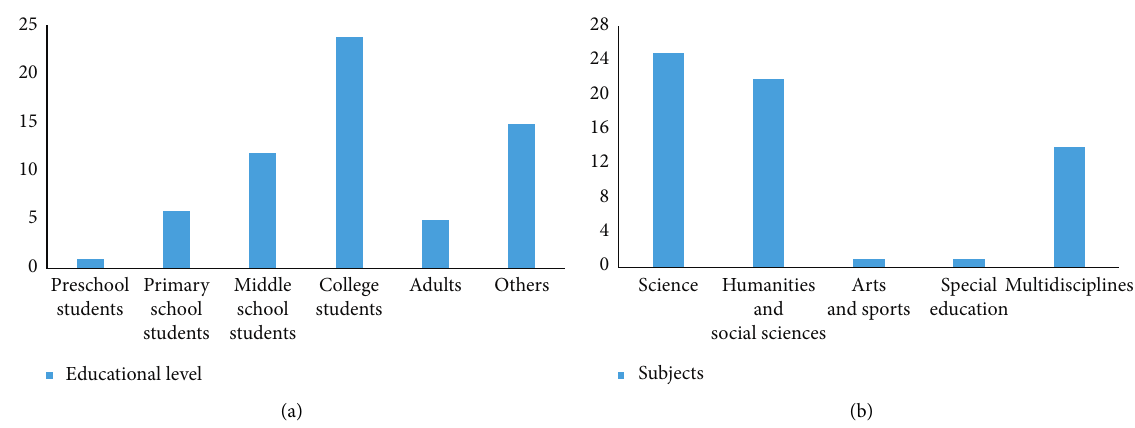
Figure 2: The number of reviewed studies by educational level and